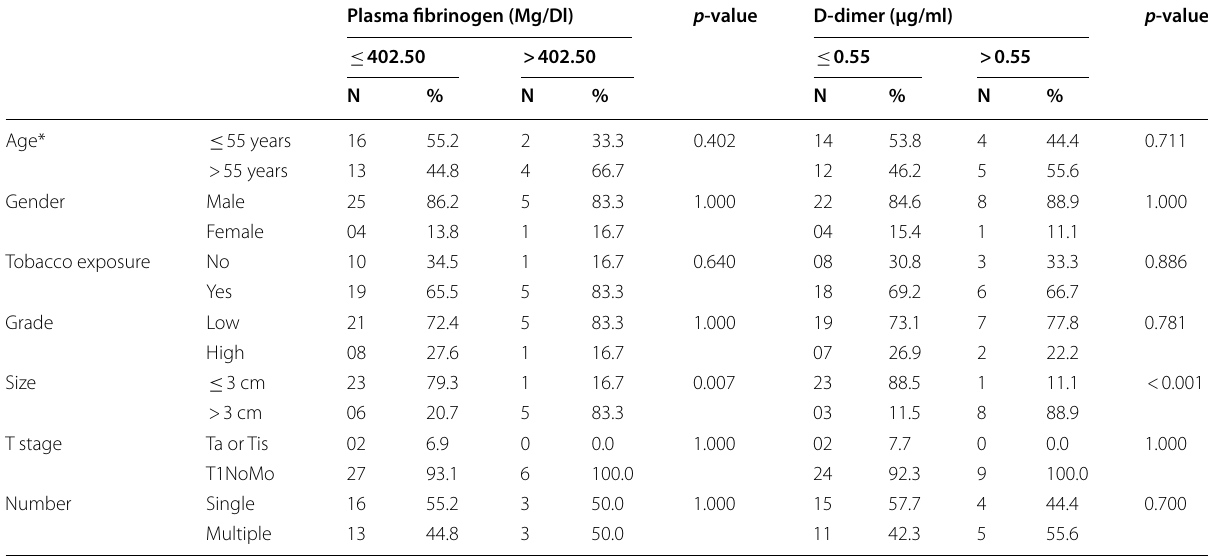
Table 2 Relationship between patient’s demographic, clinico-pathological characteristics and coagulation